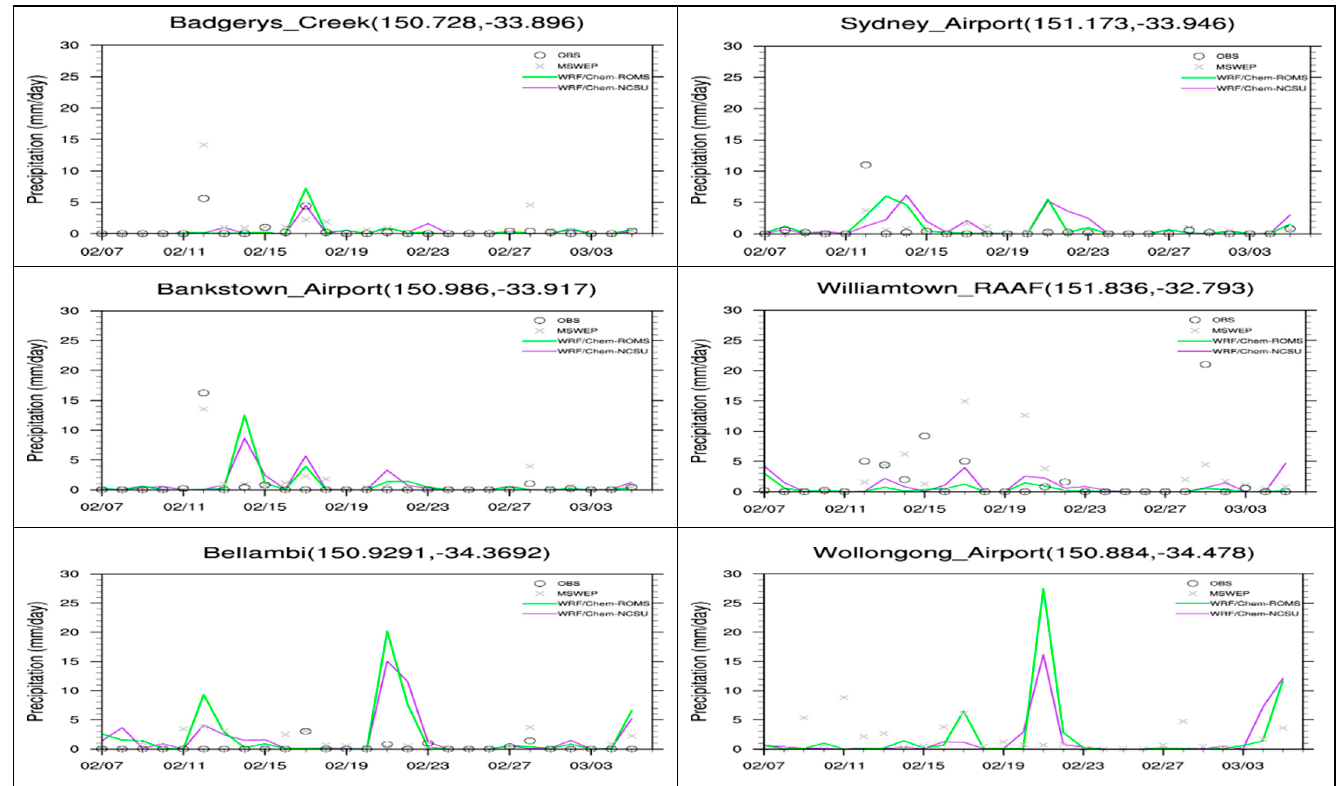
Figure 8. Observed and simulated temporal profiles of precipitation at selected sites over Greater Sydney at 3 km (d04) during SPS1. Two sets of simulation results at 3 km are compared, one from WRF/Chem-NCSU and one from WRF/Chem-ROMS.